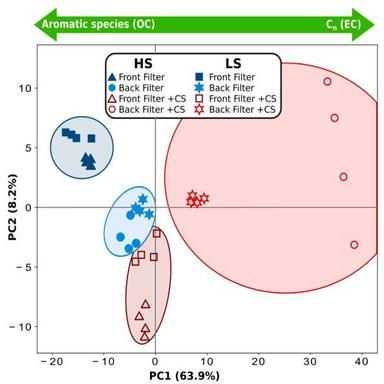
Score plot of the first two principal components for the particulate and gas phase samples collected with and without the CS in two different engine regimes (HS and LS). The arrows represent the meaning of the first principal component derived from the corresponding loadings plot, Fig. S2 (Supplementary data).